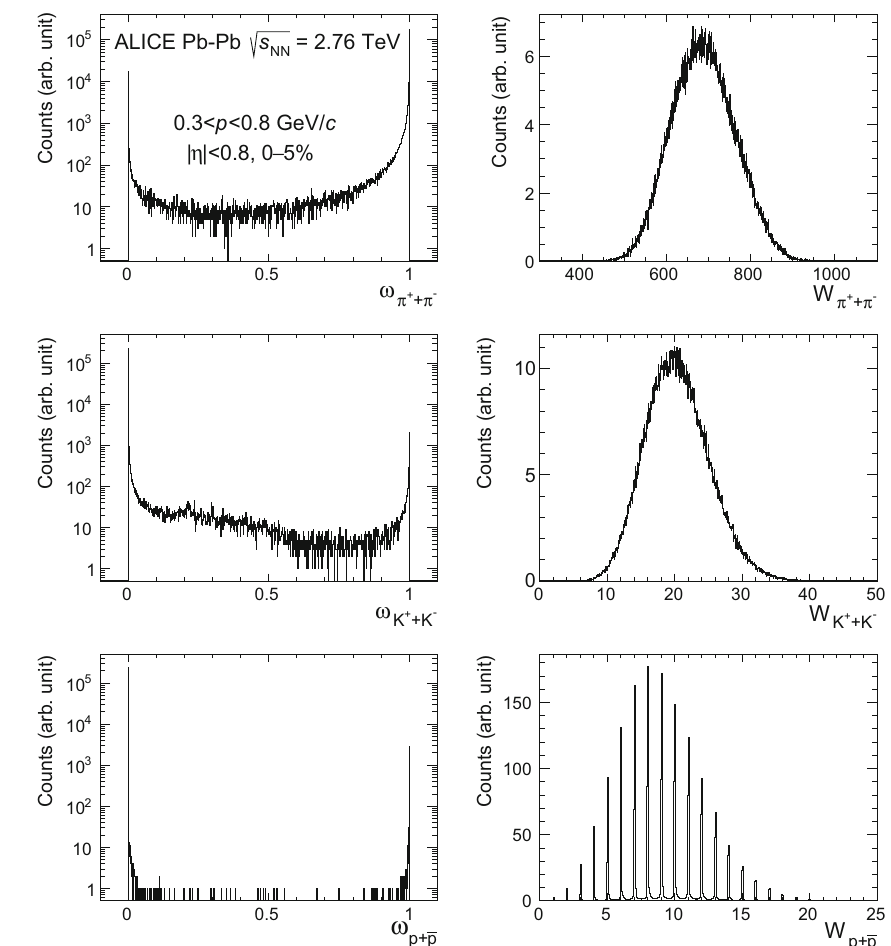
Fig. 1 Distributions of ω and W for pions (top), kaons (middle) and protons (bottom) in the momentum interval of 0 . 3 < p < 0 . 8 GeV / c for 0–5% central Pb–Pb